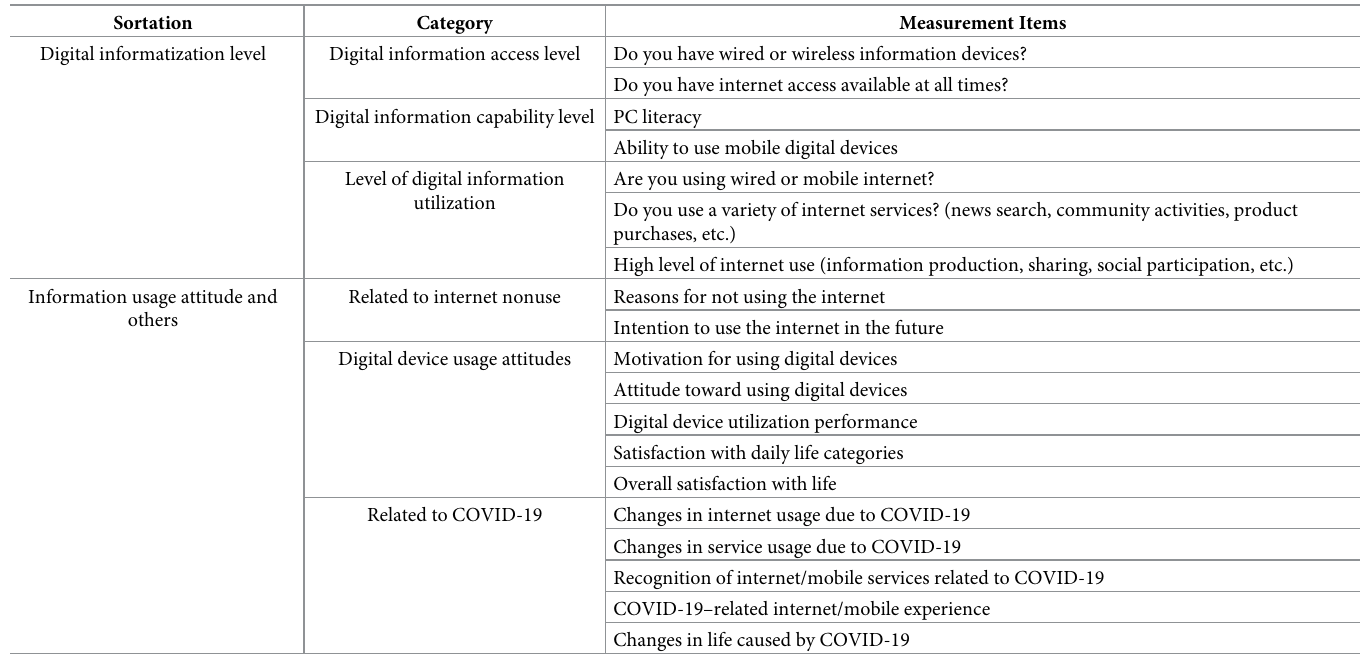
Table 1. Measurement items.